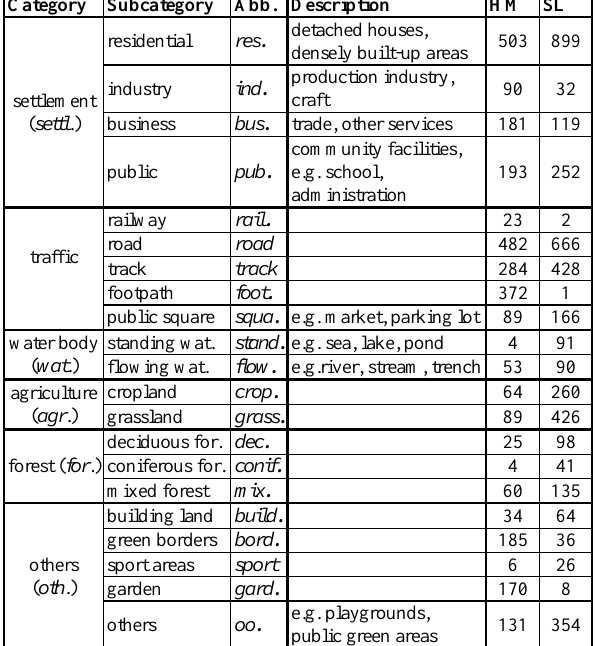
Table 1. Hierarchical class structure and number of samples for the test areas “Hameln” (HM) and “Schleswig” (SL). Abb.: abbreviation used in the remaining text.